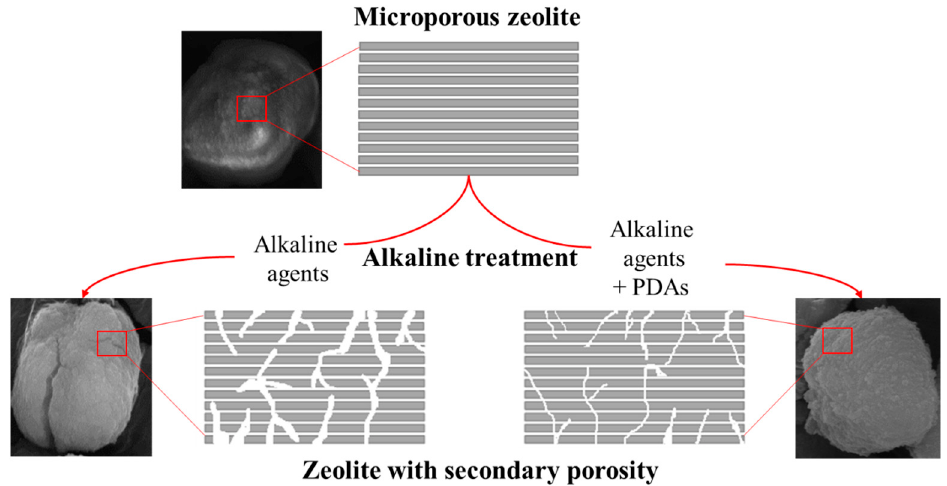
Figure 5. Illustration of alkaline treatment with and without PDAs.